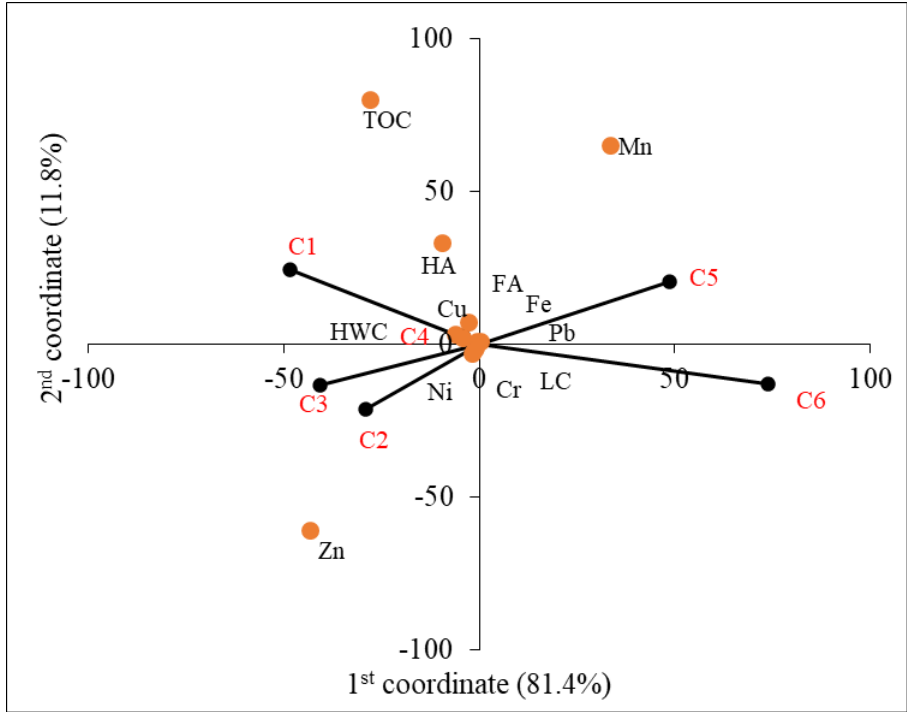
Figure 3. Canonical variate analysis showing the relationship between the individual composts (C1-C6) and analyzed parameters.